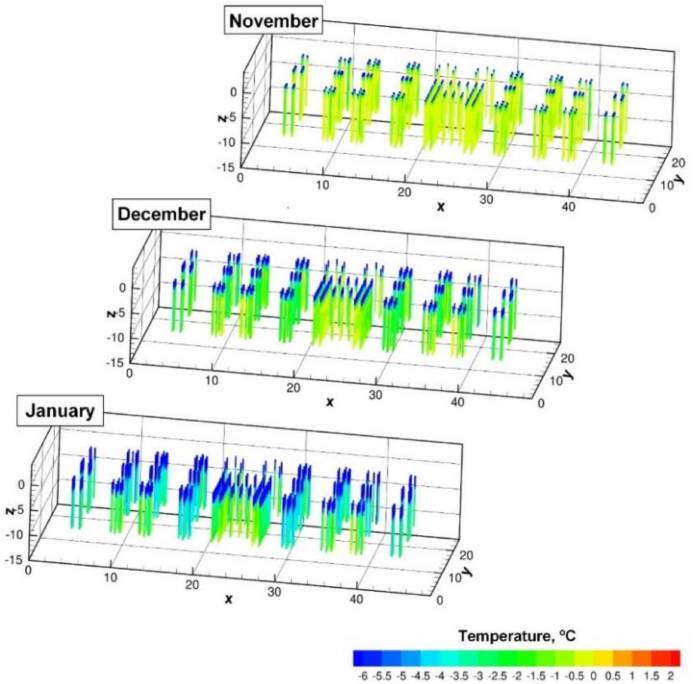
Figure 9. Temperature on the pile surfaces in November 2020, December 2020, and January